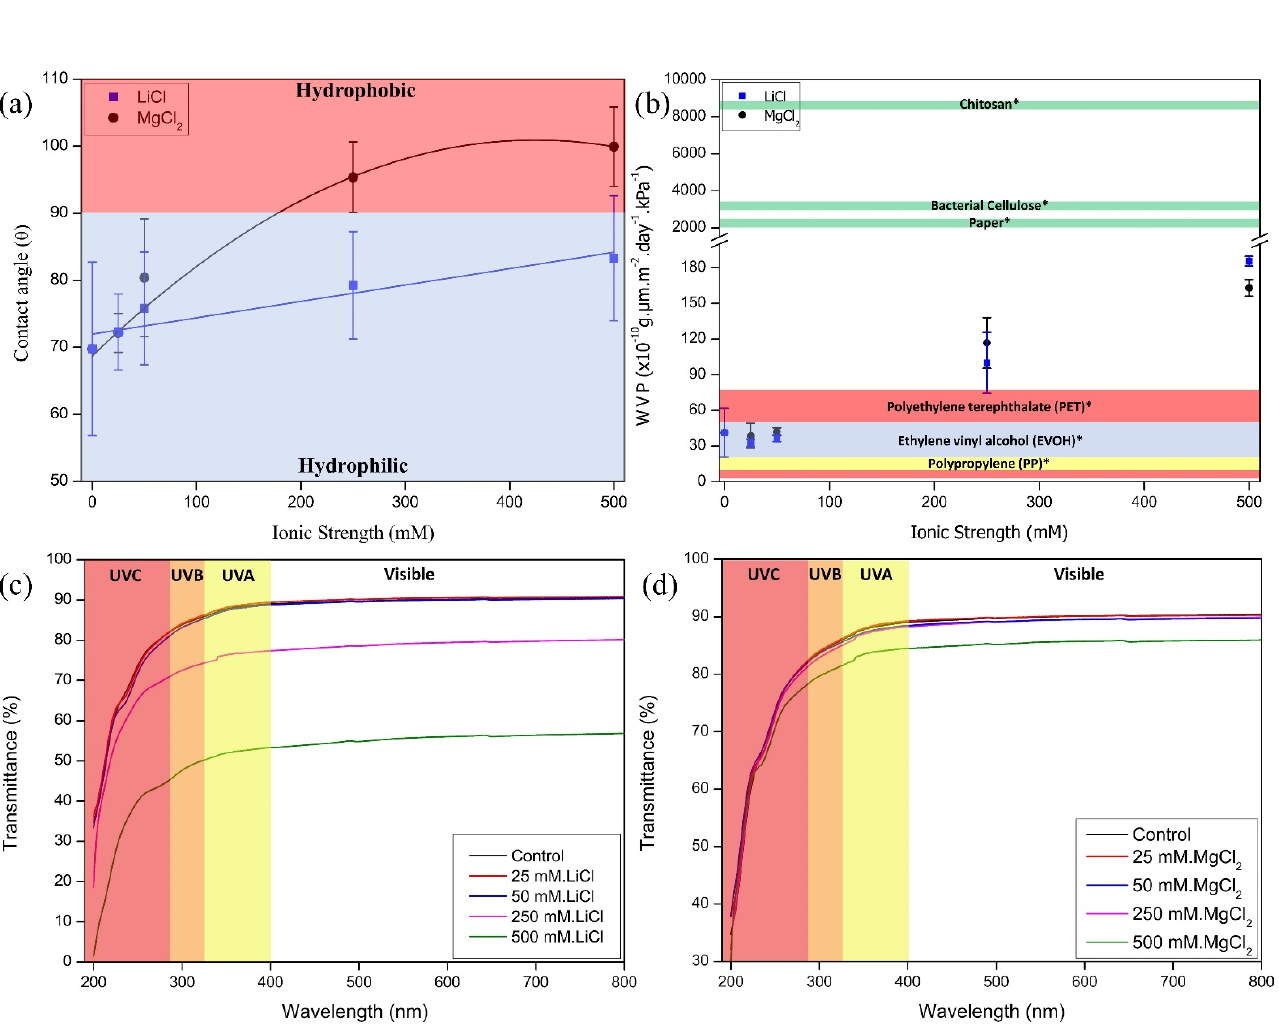
Figure 2. Contact angle ( θ ) measurement results between water and the surface of MC-based films with 0, 25, 50, 250 or 500 mM due to LiCl ( a ) or MgCl 2 ( b ) addition (the obtained models are presented in the Supplementary Materials). WVP results from MC-based films with 0, 25, 50, 250, and 500 mM due to LiCl or MgCl 2 addition and other conventional commodity plastics (PET, PP, and EVOH) and other films from renewable sources (Chitosan, bacterial cellulose, and paper) ( b ). The transmittance of MC-based films with 0, 25, 50, 250, and 500 mM due to LiCl ( c ) or MgCl 2 addition ( d ). Photographs of the films are shown in Figure S1 of the Supplementary Materials. * WVP values of conventional and renewable source films according to Wang et al. [27].